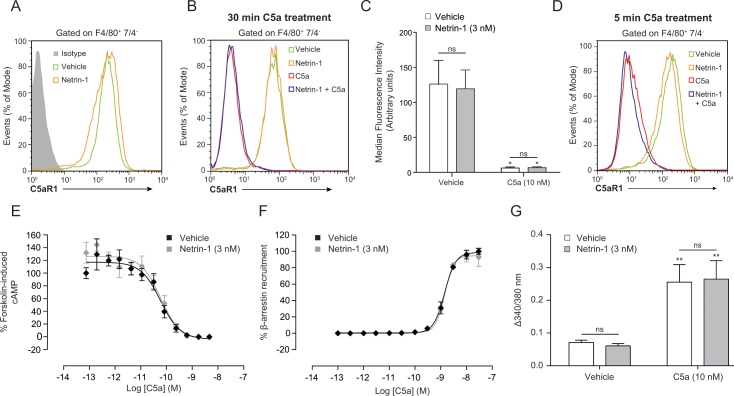
Netrin-1 does not inhibit C5aR1 proximal signalling events.BMDMs were incubated with either vehicle of 3 nM netrin-1 for 45 min at 37°C, 5% CO2 prior to being stimulated with either vehicle or 10 nM C5a for the time indicated. Cells were then subjected to antibody staining for surface levels of F4/80, 7/4 and C5aR1. Representative flow cytometry histograms of BMDM (defined as F4/80+, 7/4-) C5aR1 surface levels following stimulation for 30 min with either vehicle or 10 nM C5a, with and without 3 nM netrin-1 treatment are shown in (A) and (B) respectively. (C) Quantification of C5aR1 surface levels by median fluorescence intensity. Data are mean + SEM, n = 3 biological replicates. (D) Flow cytometry histogram showing BMDM surface C5aR1 levels following 5 min C5a (10 nM) stimulation, with and without netrin-1 (3 nM) treatment. (E) CHO-K1 cells expressing human C5aR1 were incubated with either vehicle or 3 nM netrin-1 for 45 min at 37°C, 5% CO2. Cells were then stimulated with the indicated concentration of C5a for 30 min at 37°C, 5% CO2 and intracellular cAMP levels measured. (F) CHO-K1 cells expressing murine C5aR1 were incubated with either vehicle or 3 nM netrin-1 for 45 min at 37°C, 5% CO2. Cells were then stimulated with the indicated concentration of C5a for 90 min at 37°C, 5% CO2 and β-arrestin recruitment to C5aR1 measured. Data are mean ± SEM, n = 3 technical replicates. (G) BMDMs were seeded into 96 well black walled plates (50,000 cells/well) and incubated with 4 μM Fura 2-AM with or without 3 nM netrin-1 for 45 min at RT. Cells were then washed, the medium replaced and then stimulated with either vehicle or 10 nM C5a. Change in Fura-2 fluorescence at 340 nm/510 nm and 380 nm/510 nm was calculated. Data are mean + SEM, n = 3 biological replicates with 2 technical replicates per condition. Statistical analysis was conducted by two-way ANOVA with Sidak’s multiple comparisons correction. ns P > 0.05, for indicated comparisons and * P < 0.05, ** P < 0.01, compared to the respective vehicle control.